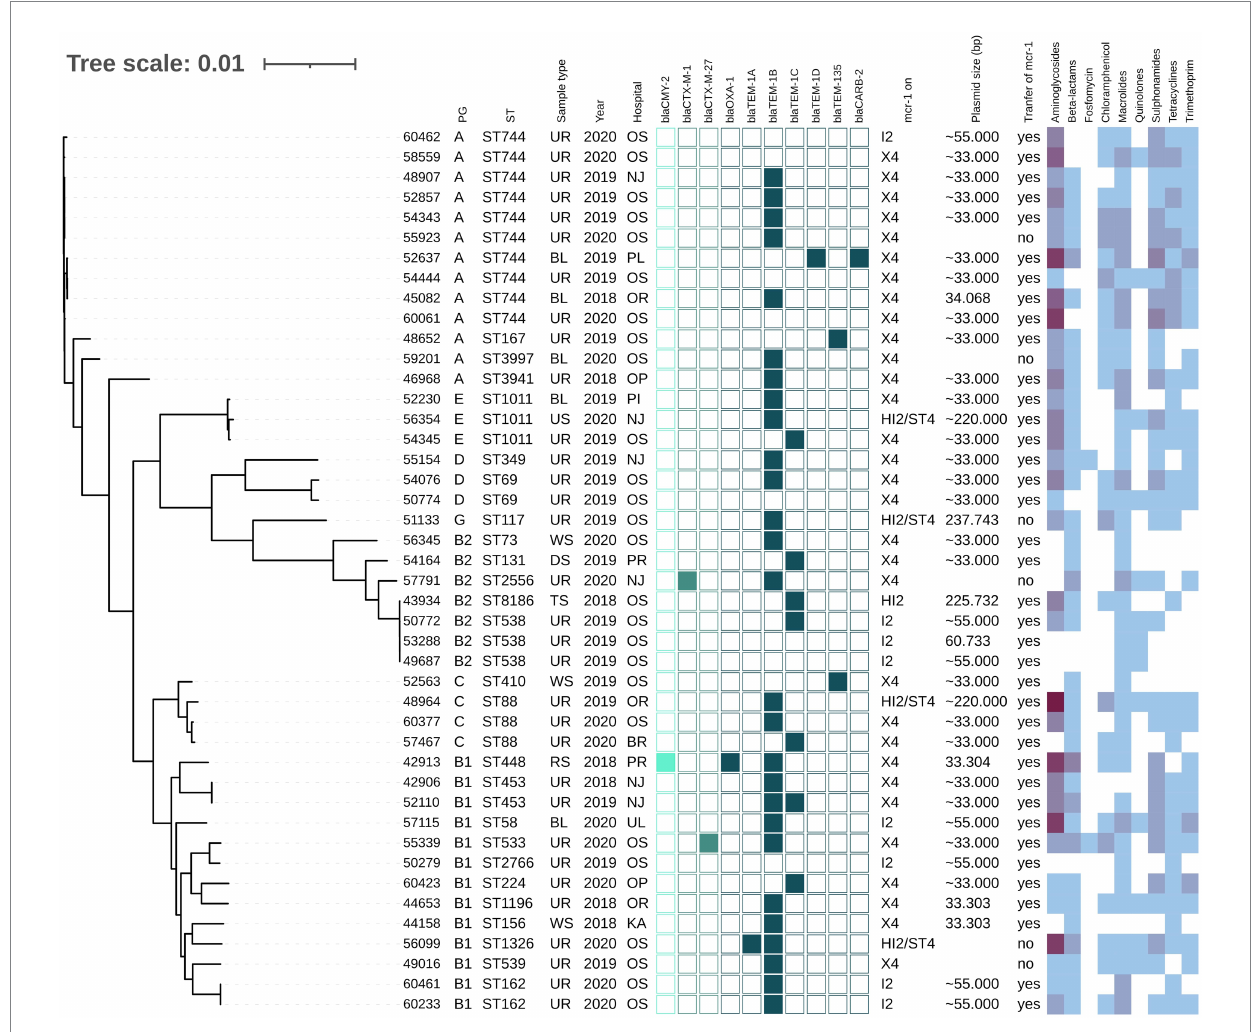
FIGURE 1 Phylogenetic tree of E. coli isolates with mcr-1 of Czech clinical origin. The metadata in columns represents phylogenetic group (PG); sequence type (ST); type of sample (Sample type): urine (UR), blood (BL), rectal swab (RS), tonsil swab (TS), wound swab (WS), decubitus swab (DS), urethra swab (US); year of isolation (Year) and city where is the hospital related to the isolate recovery (Hospital): Novy Jicin (NJ), Prague (PR), Ostrava (OS), Karvina (KA), Ostrava-Poruba (OR), Opava (OP), Pribram (PI), Plzen (PL), Usti nad Labem (UL), Brno (BR). The turquoise squares represent presence (full square) or absence (empty square) or respective beta-lactamase encoding genes divided as AmpC (bright turquoise), ESBL (medium) and narrow-spectrum beta- lactamases (dark).The next section (mcr-1 on) reveals which plasmid carried mcr-1 gene; the size of the plasmid (Plasmid size) in bp while approx. Sizes (~) are estimated based by S1-PFGE, while the more precise values come from plasmid sequencing; the success of conjugative transfer is indicated (Transfer of mcr-1). The heat map in the last section indicated the amount of antibiotic resistance genes carried by the respective isolate in specified category of antibiotics from zero (white) to maximum of six (dark